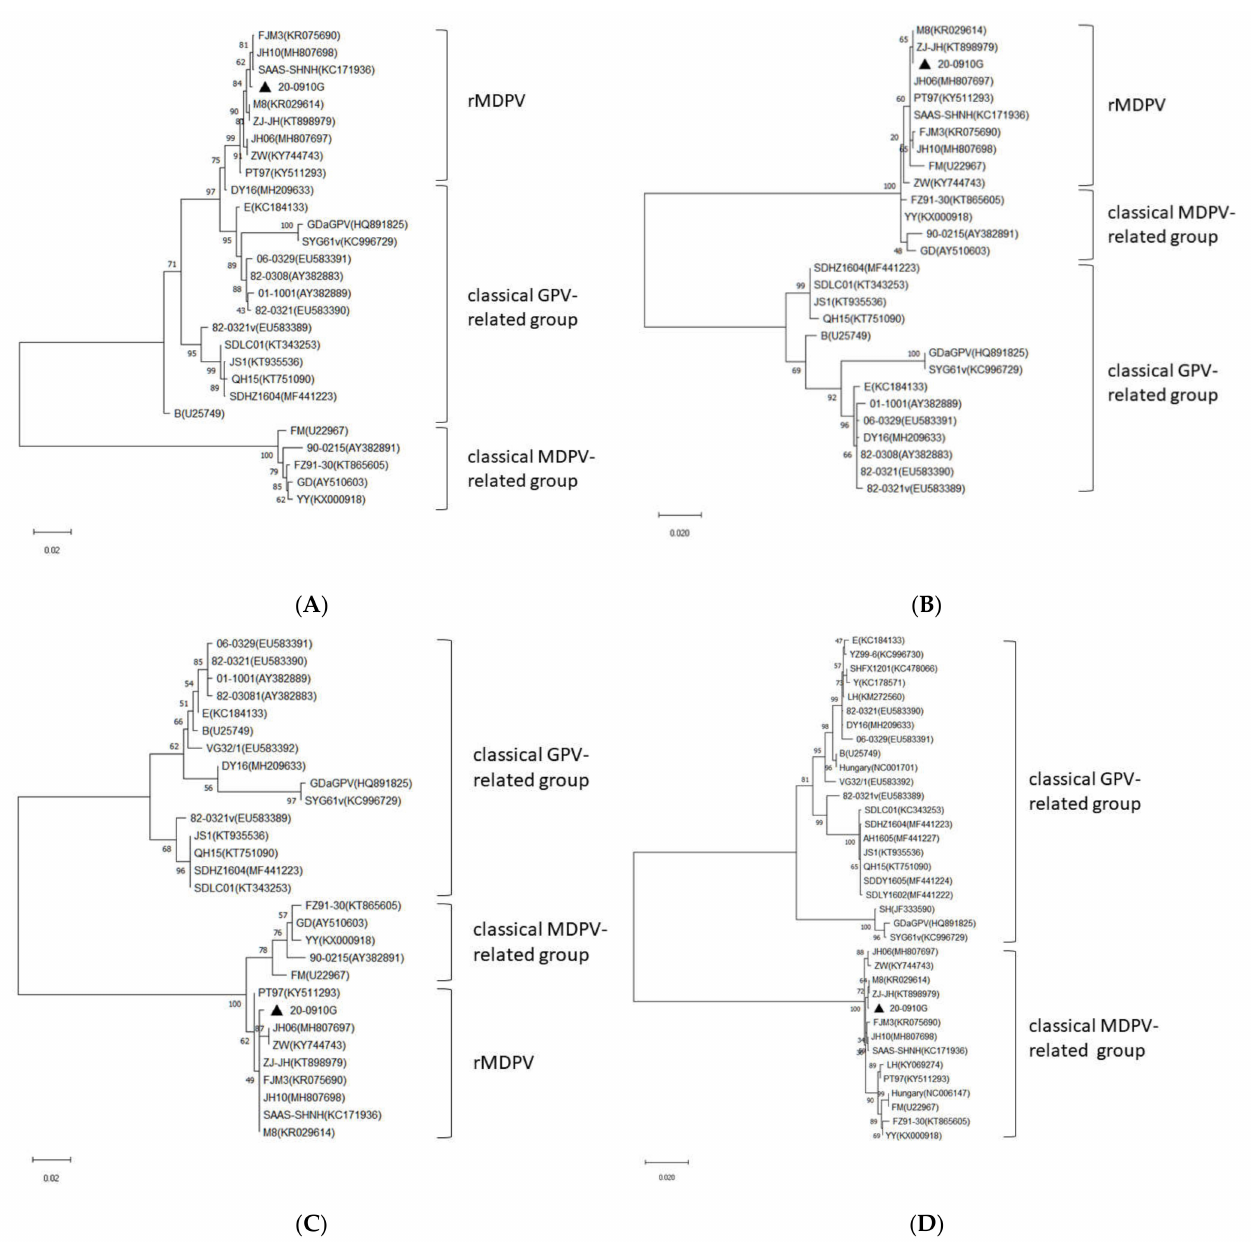
Figure 2. Phylogenetic analyses based on the nucleotide sequences from ( A ) the central 1.1-kb segment of VP1 (nucleotide positions 3121–4251); ( B ) the N-terminal 700-bp segment of VP1 (nucleotide positions 2419–3118); ( C ) the C-terminal 400-bp segment of VP1 (nucleotide positions 4218–4617); ( D ) the NS gene. All analyses were performed with the maximum- likelihood method. Relative bootstrap values were indicated at the nodes by 1000 replicates. Sequence determined in the present study is marked with a